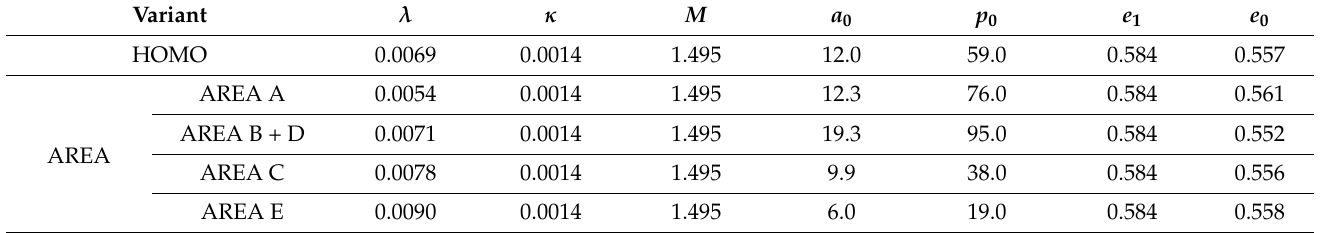
Table 6. Derived Modified Cam-Clay parameters for the full building-subsoil model.